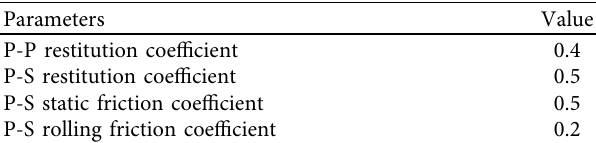
Table 4: Nonsignificantly affected